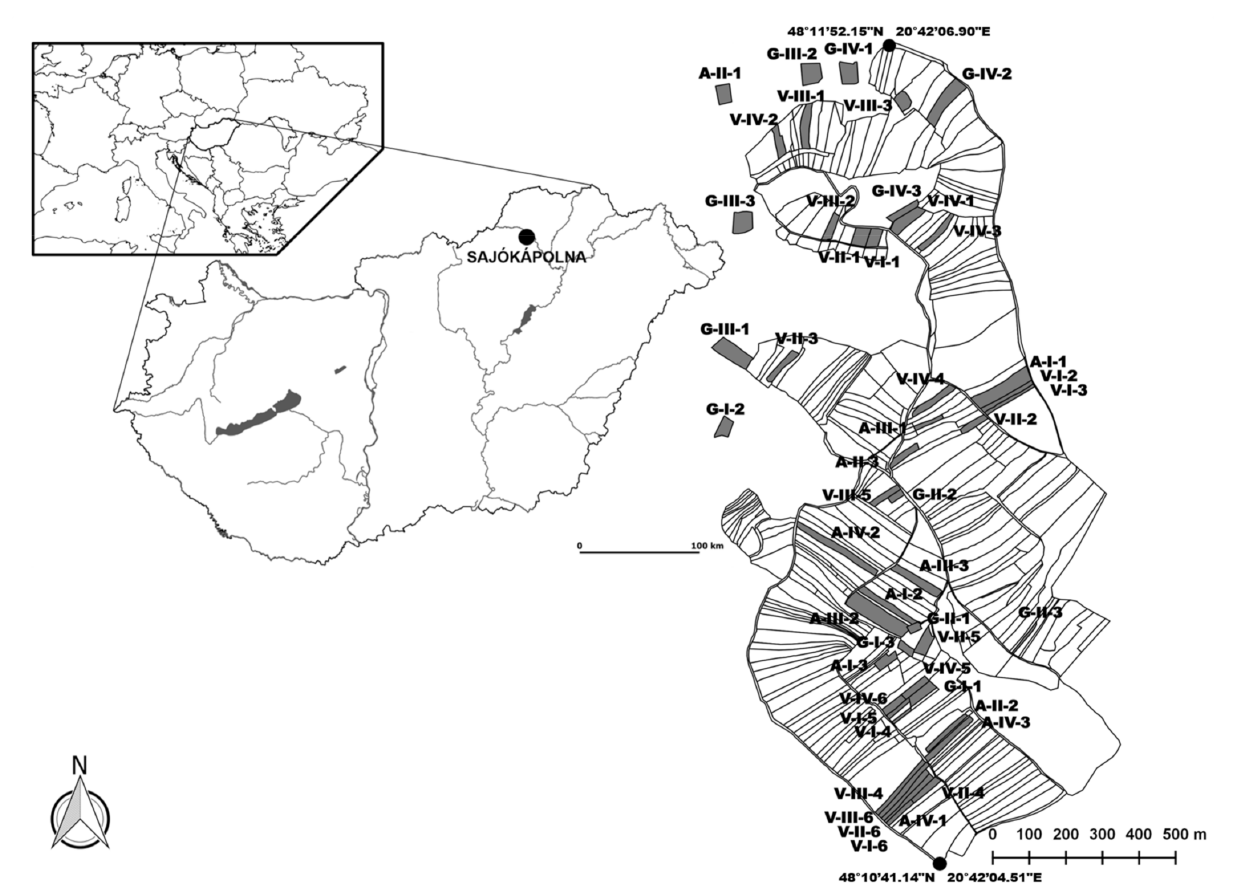
Figure 1. Location of the study site and studied plots—based on a cadastral map (1971) and fieldwork (The inicial letters indicate the type of abandonment: V—vineyards, A—arable land, G—grasslands; the middle latin numbers indicate the period of abandonment I: 1–5 years, II: 6–10 years, III: 11– 20 years, IV: 21–30 years; the last Arabic numbers indicate the plots examined; the arrow shows